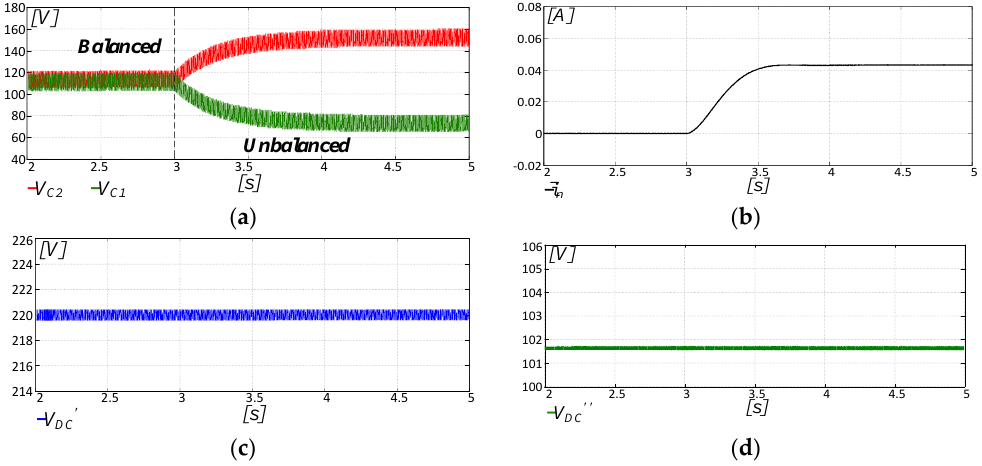
Figure 14. Averaged-value model. ( a ) DC bus capacitor voltages V C1 and V C2. ( b ) i n = i C1 − i C2 . ( c ) output voltage V DC '. ( d ) TLI DC bus voltage V DC ''.